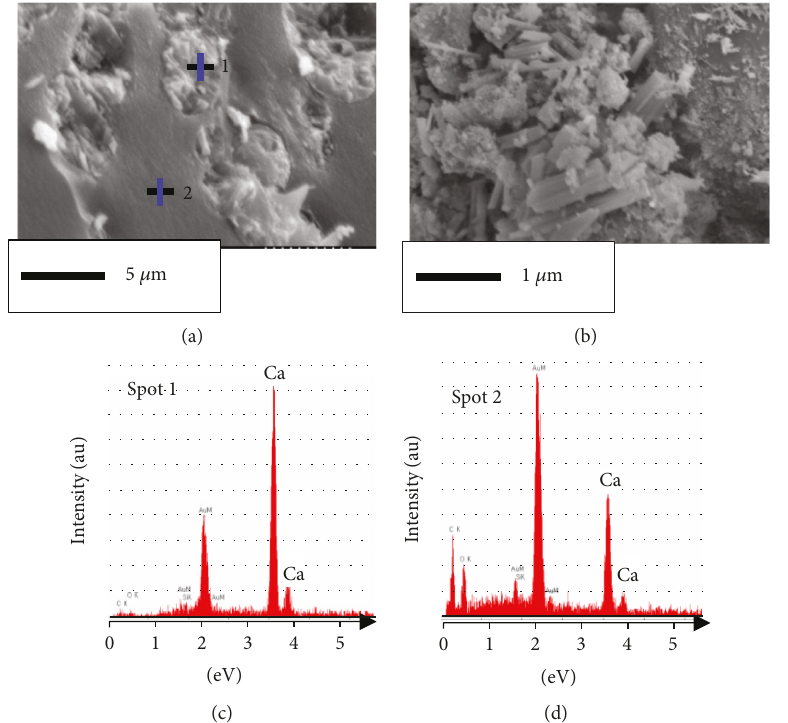
– polymer nanocomposite sample (a and b) and corresponding 3